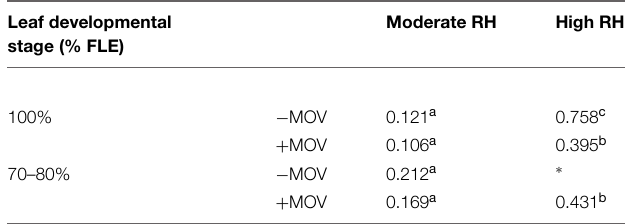
TABLE 3 | Abscisic acid intake required to reduce the transpiration rate to half-way (50%) between the maximum and minimum values (EC 50 ) in fully developed leaflets (100% FLE) and non-fully developed leaflets (70–80% FLE) of pot rose cv. Toril grown at moderate (61%) or high (92%) RH, without ( − MOV) or with ( + MOV) additional